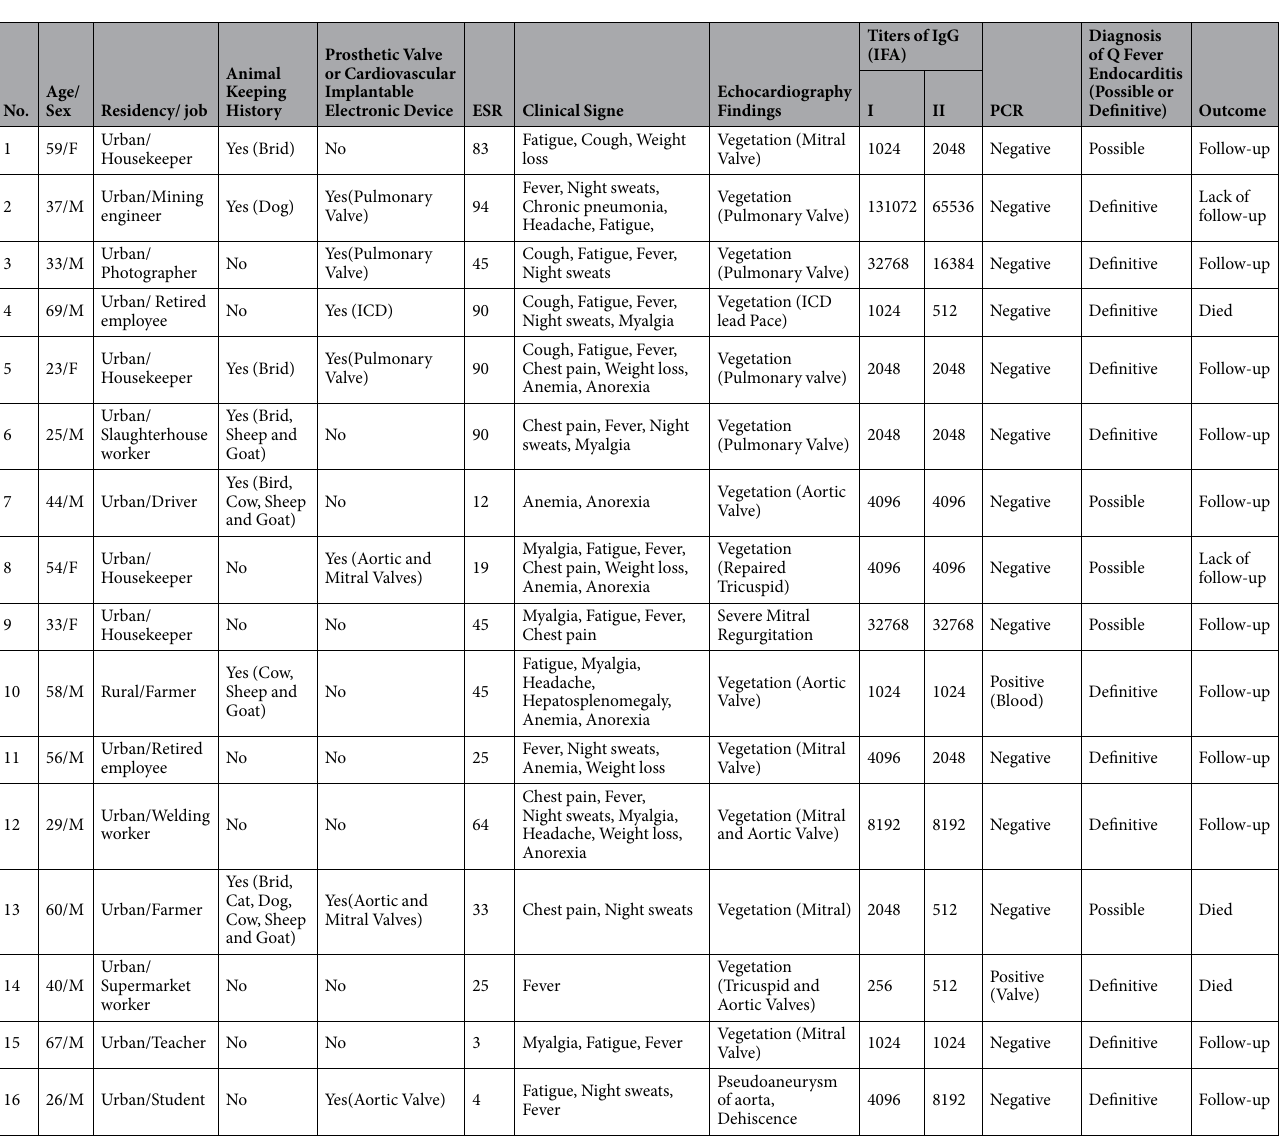
Table 2. Epidemiological factors, laboratory and clinical findings of patients with Q fever endocarditis hospitalized in Rajaie Cardiovascular Medical and Research Center, Tehran,